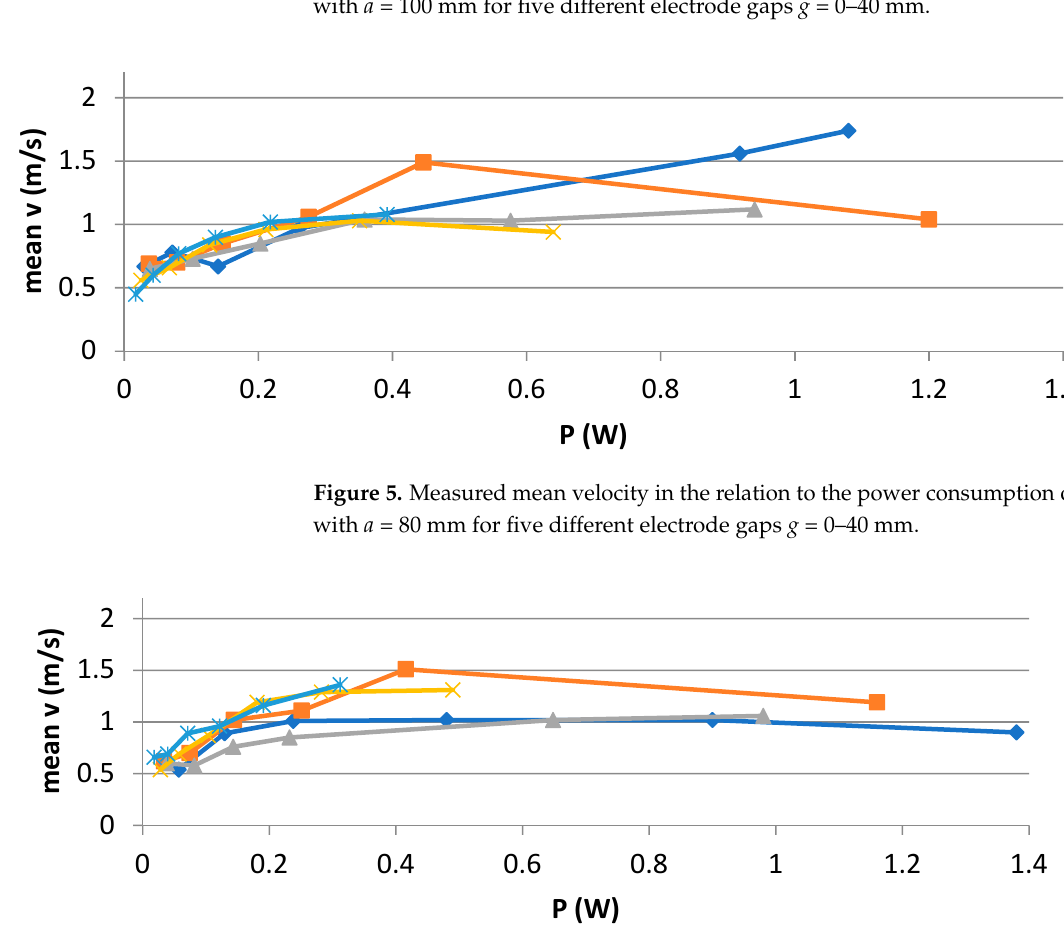
Figure 6. Measured mean velocity in the relation to the power consumption on the airflow generator with a = 60 mm for five different electrode gaps g = 0–40 mm.